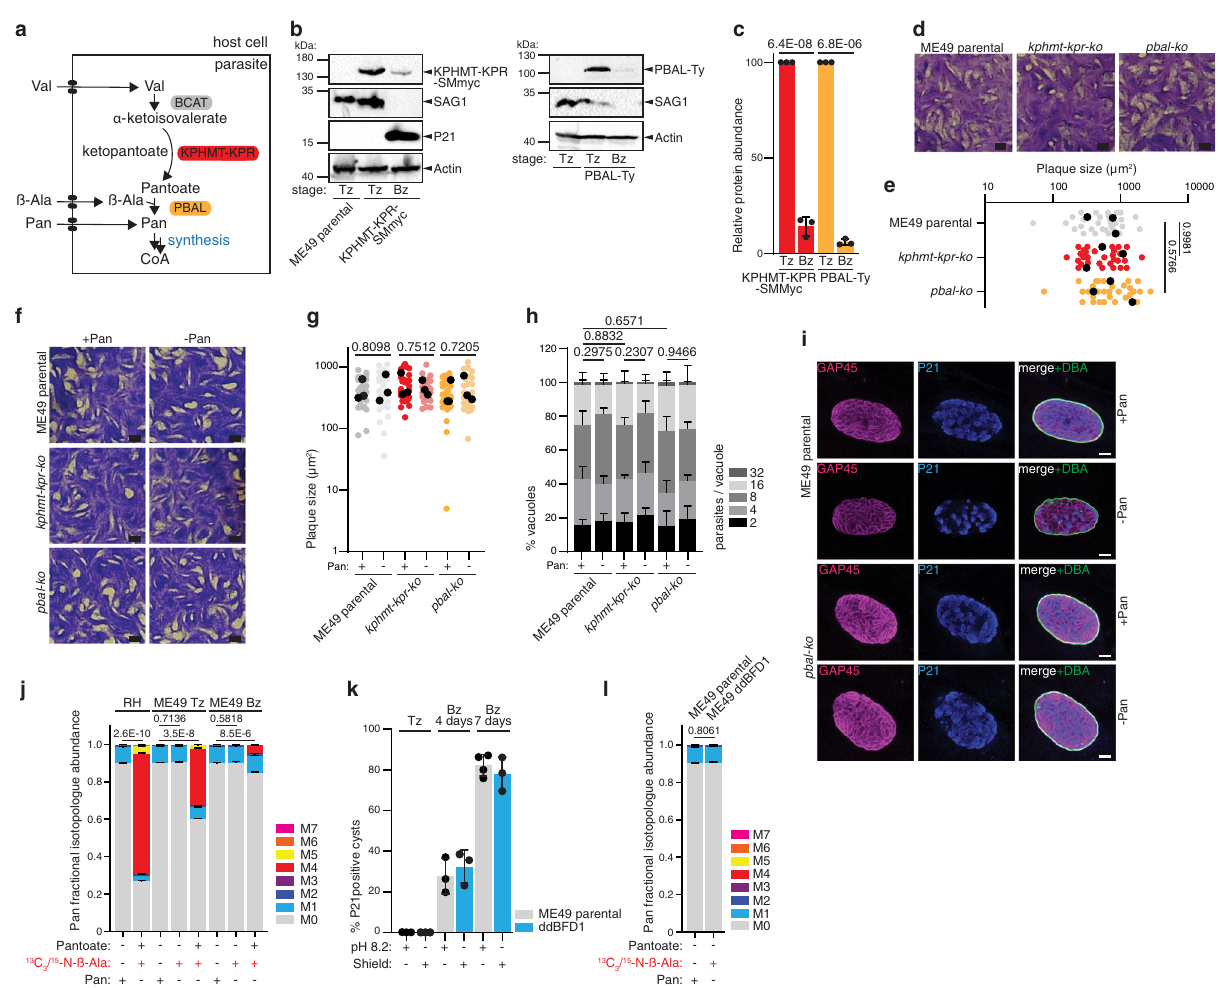
Fig. 7 De novo Pan synthesis is dispensable and inactive in in vitro differentiated bradyzoites. a Scheme of the Pan biosynthesis pathway, highlighting the ketopantoate hydroxymethyltransferase - ketopantoate reductase (KPHMT-KPR) and the pantoate beta alanine ligase (PBAL). See Fig. 1 for abbreviations. b Western blot of KPHMT-KPR-SMmyc ( n = 3) and PBAL-Ty ( n = 3) of 1-week alkaline medium differentiated bradyzoites. Antibodies anti myc and Ty, anti SAG1 (tachyzoite markers), anti P21 (late bradyzoite marker), anti actin as loading control. c quanti fi cation of protein levels, relative